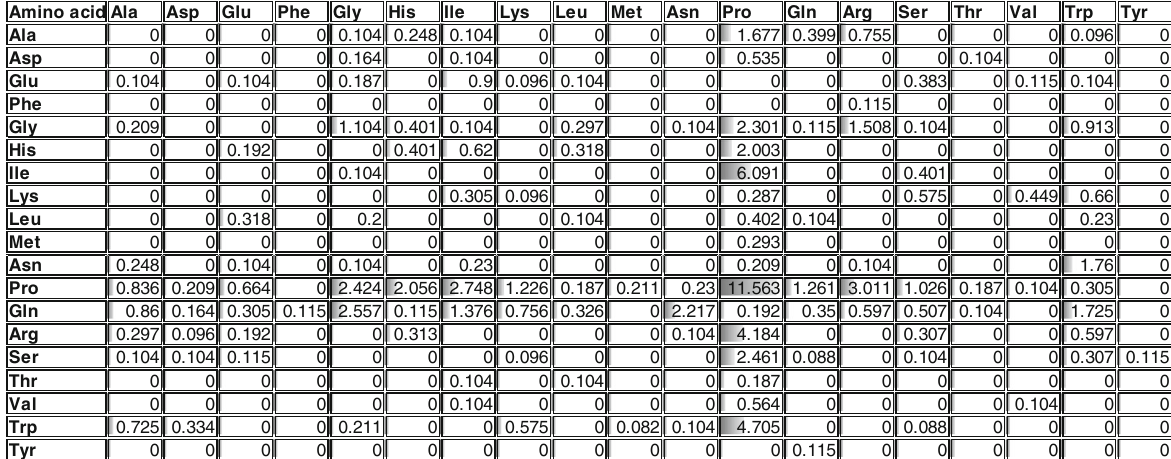
Table 3 Dipeptide frequency distribution Amino acid